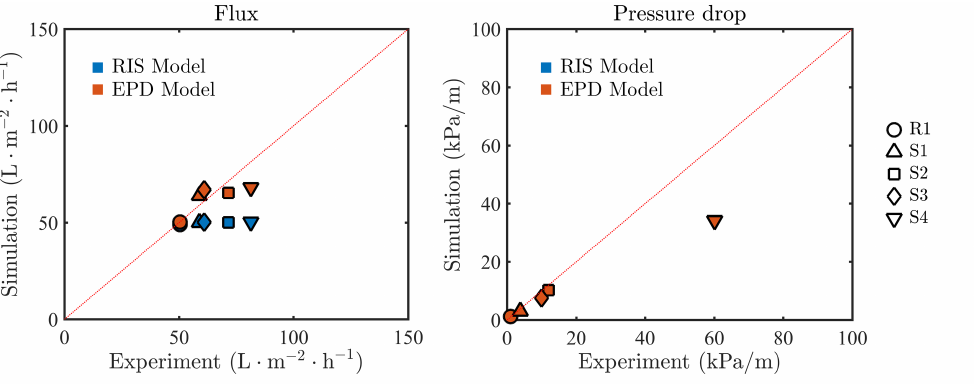
Figure 5. Comparison between the simulated permeate flux and pressure drop and the experimental results. Different shapes indicate results of different channel shapes, and the blue and red markers represent the RIS and the EPD models,